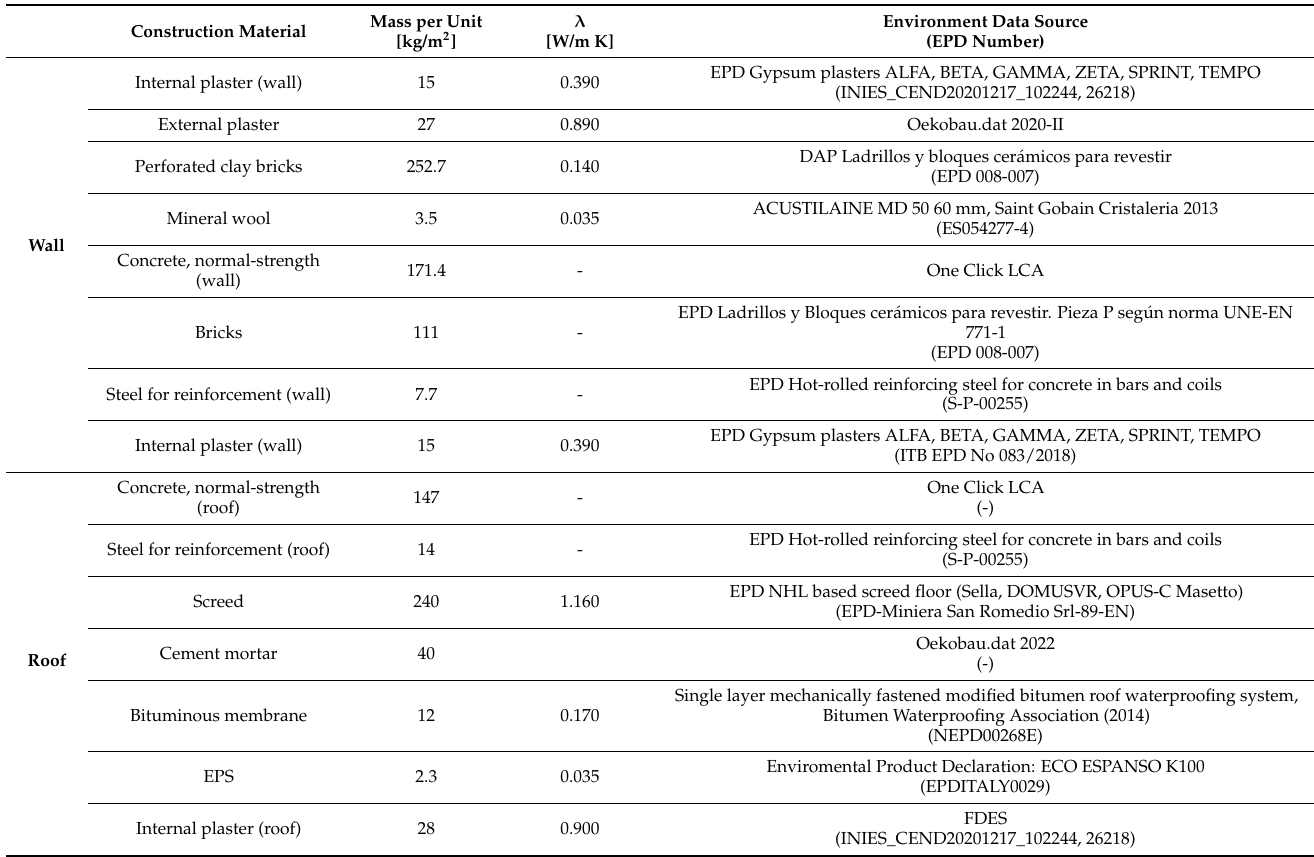
Table 10. Bill of material, thermal conductivity and data source: traditional configurations for 1 m 2 of wall and roof.